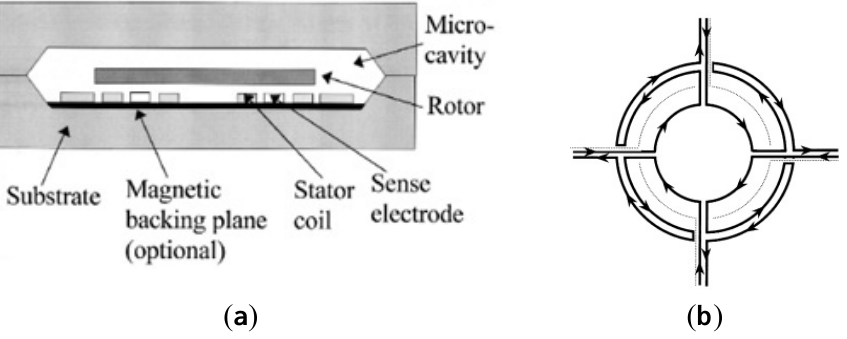
Figure 15. Schematic diagrams. ( a ) Cross-section view of a levitated micro-rotating gyroscope. ( b ) The four-phase